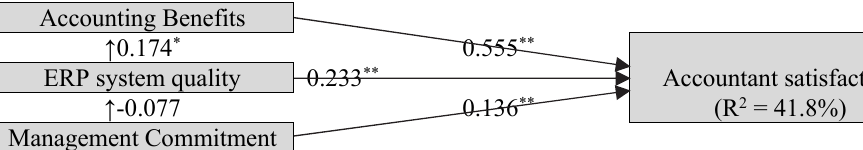
Fig. 3. Results of our proposed